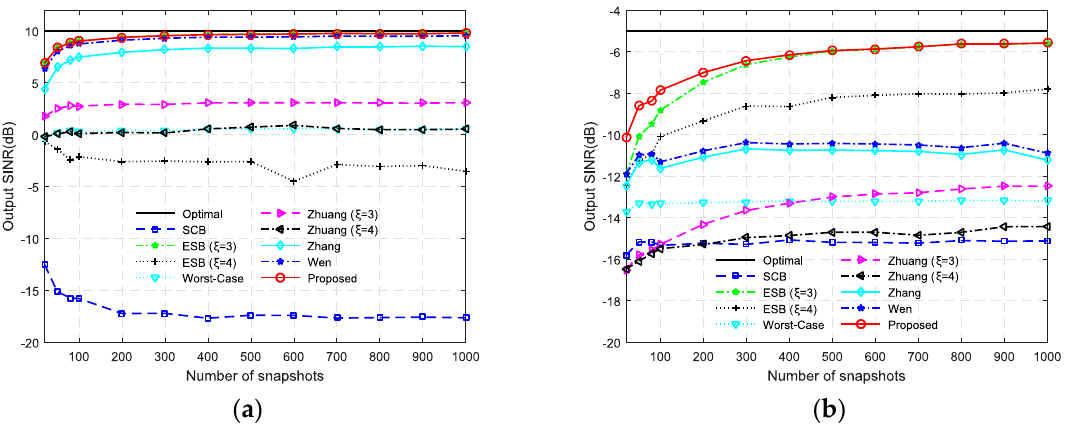
Figure 5. Output SINR versus the number of snapshots for: ( a ) SNR = 0 dB; and ( b ) SNR = − 15 dB.